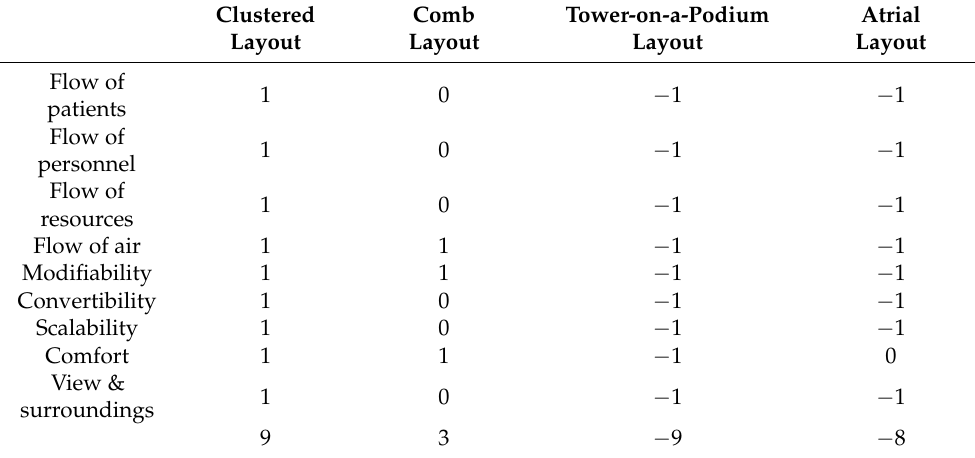
Table 3. Efficiency of different spatial layouts in an emergency scenario requiring an extremely large number of patients to be admitted in a very short time (compound disaster, terrorist or military attack,